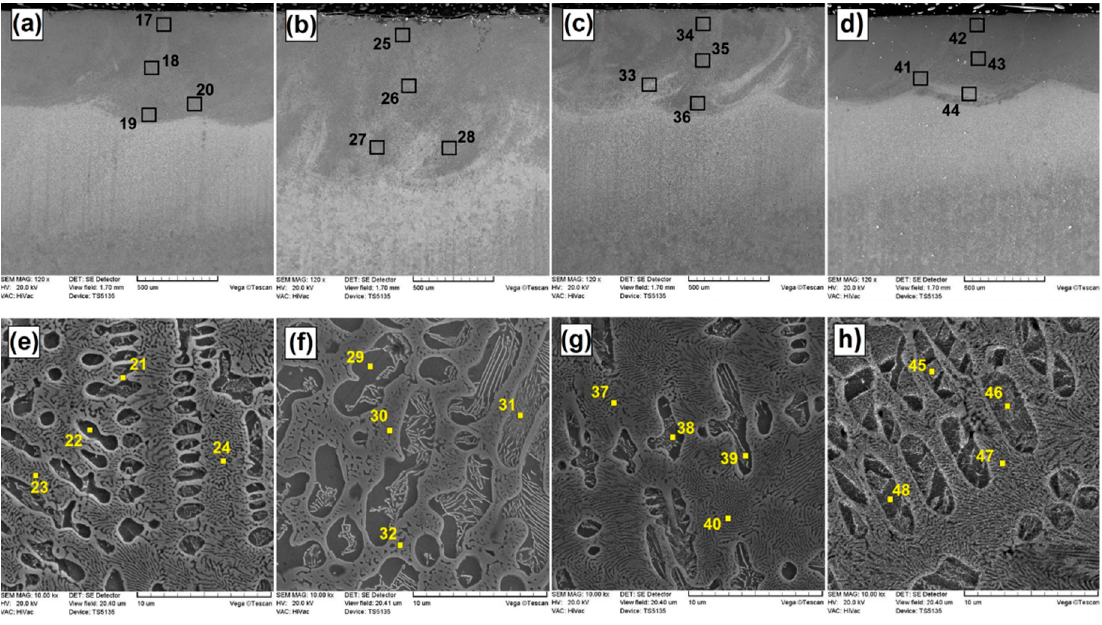
Figure 5. Microstructure of Fe–B–B 4 C–Si coatings: ( a ) laser tracks of #3; ( b ) laser tracks of specimen #4; ( c ) laser tracks of specimen #5; ( d ) laser tracks of specimen #6; ( e ) remelted zone of specimen #3; ( f ) remelted zone of specimen #4; ( g ) remelted zone of specimen #5; ( h ) remelted zone of specimen #6 (specimens numbers in accordance with Table 2).